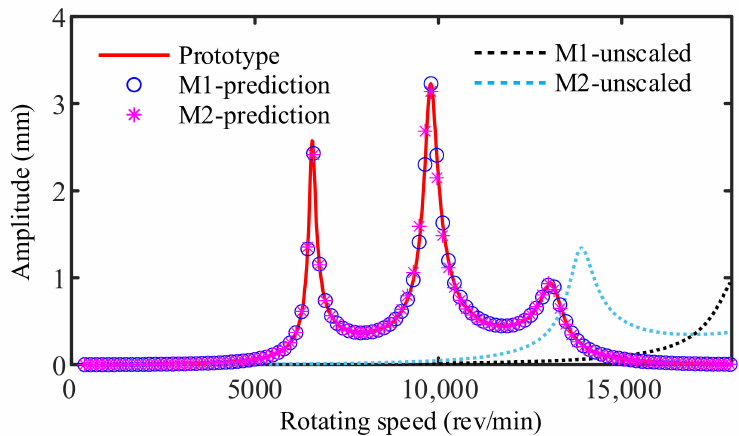
Figure 13. Prediction of AFR from M1 and M2 under HP rotor